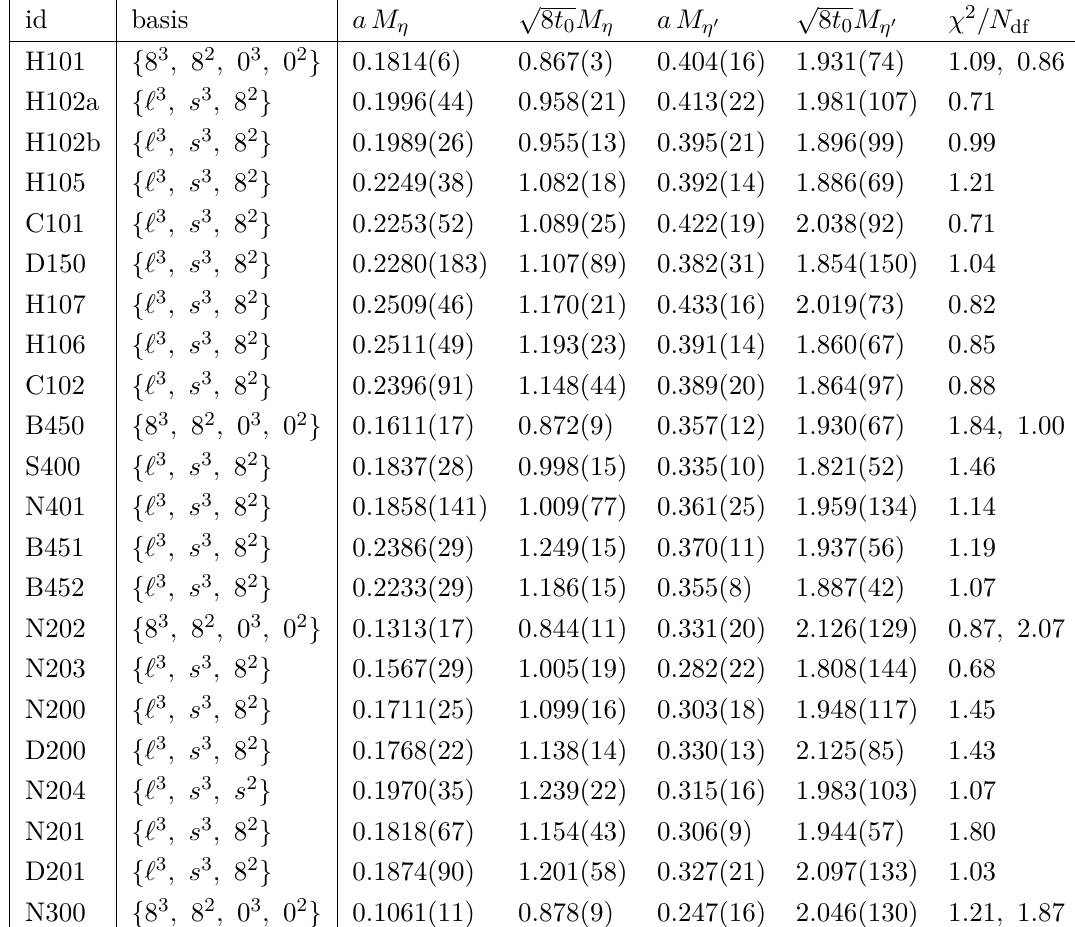
Table 4. Masses of the η and η 0 mesons obtained from fits to eqs. (4.9) and (4.15) in lattice units √ and in units of the gradient flow scale, 8 t 0 (determined on the same ensemble). See table 1 for the corresponding pion and kaon masses and table 2 for the lattice spacings. We also give the smearing bases used in the construction of the matrix of correlation functions, eq. (4.1), where ‘, s, 8 , 0 refer to the light, strange, octet and singlet combinations of the pseudoscalar interpolating operators, respectively, and the superscript labels the smearing applied (element of S ), see table 3. The resulting χ 2 /N df of the partially correlated fits are also given. For the ensembles with m s = m ‘ , where we carry out two independent fits, we give both χ 2 /N df values for the octet (first) and singlet (second) cases. Ensembles H102a and H102b were generated with the same quark masses and lattice coupling but different simulation parameters and are therefore analysed